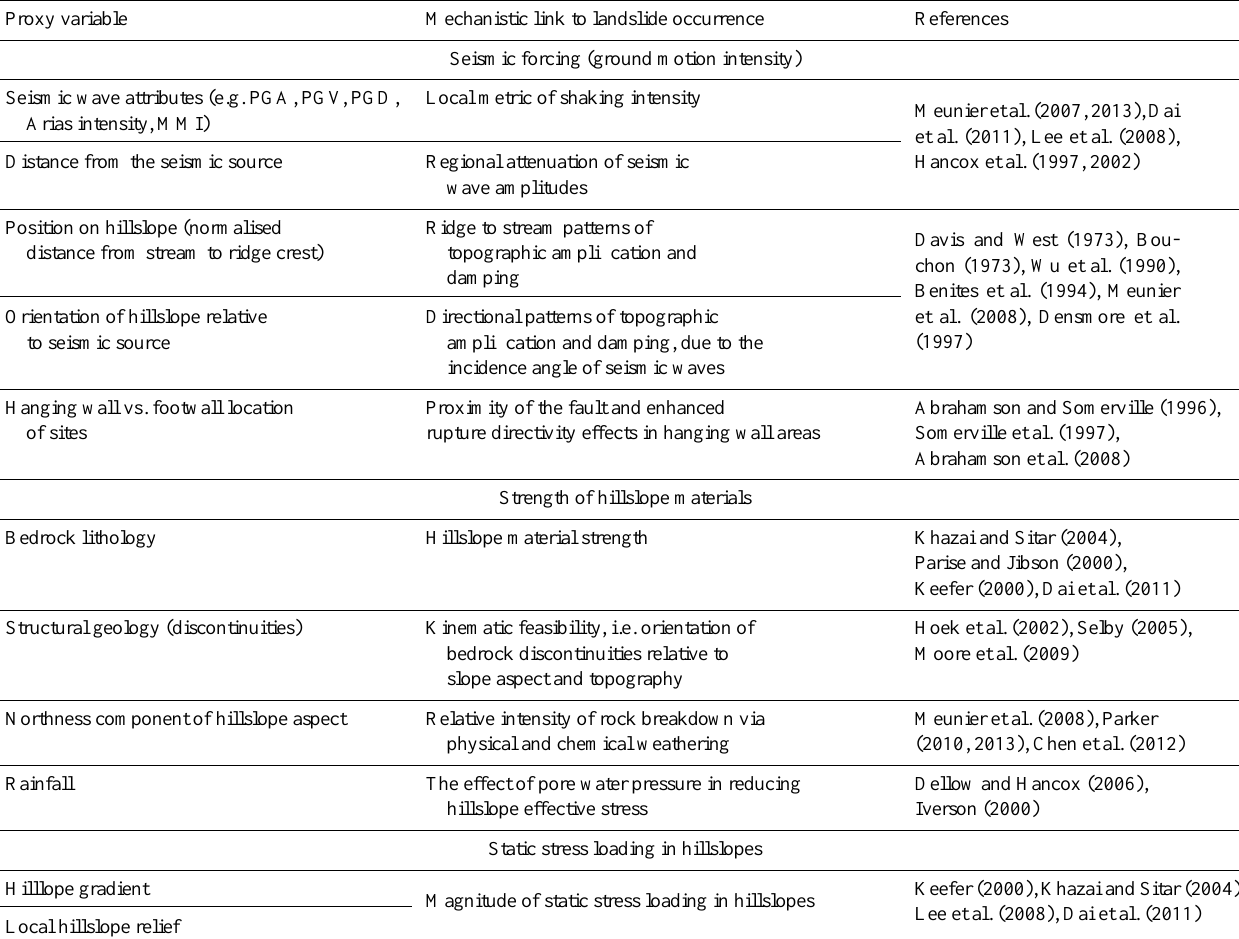
Table 2. Summary of proxy variables suggested to influence spatial distributions of earthquake-induced landslides, based on empirical